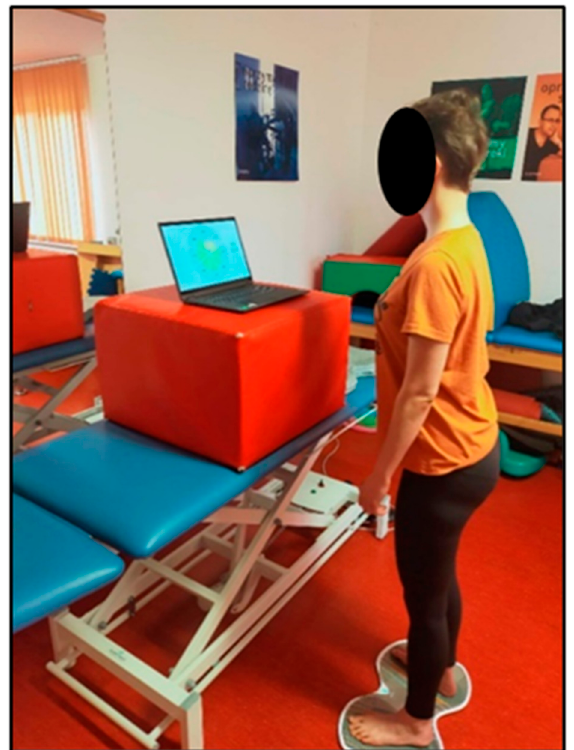
Figure 3. Performing measurements on the TYMO ® platform (own source).